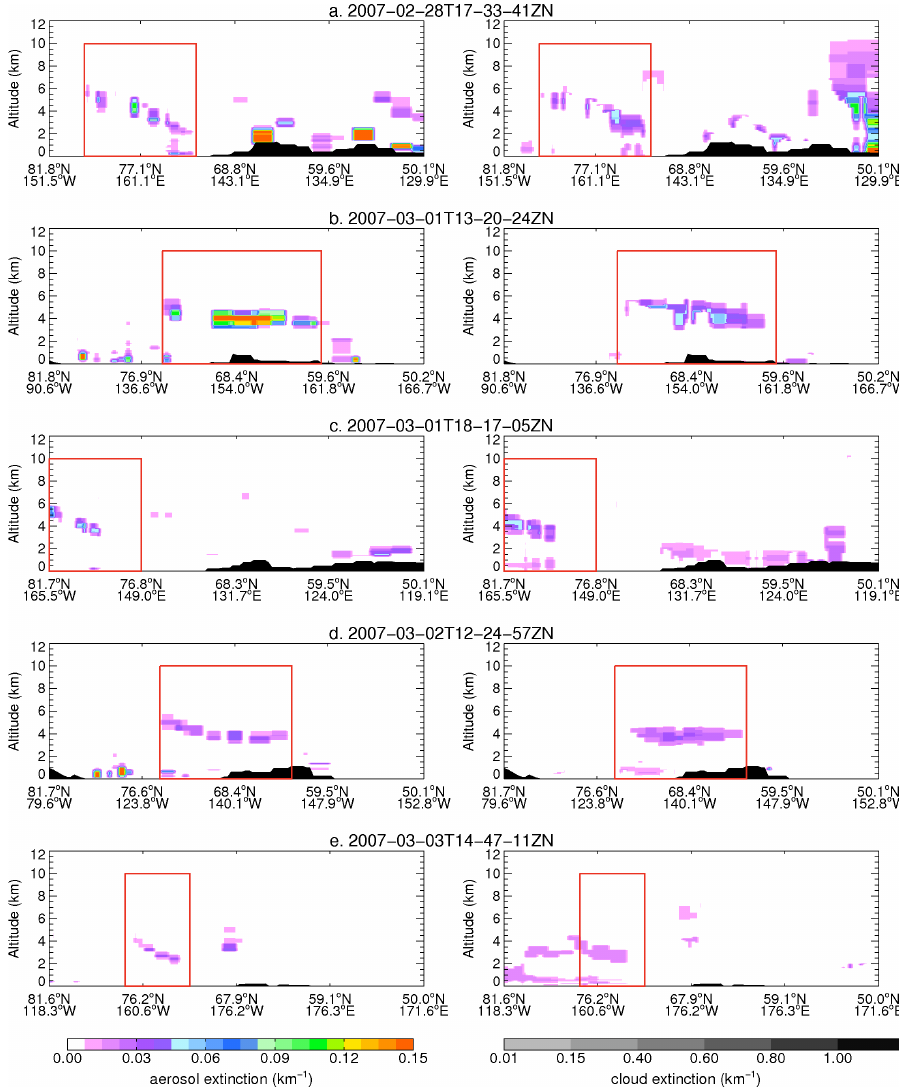
Figure 4. Same as Figure 2, but with the CALIOP extinction gridded onto the GEOS-Chem horizontal and vertical grid (left panels). The GEOS-Chem extinction cross sections (right panels) take into account the CALIOP altitude-dependent backscatter sensitivity threshold. In addition, model extinction is displayed only under cloud free conditions for better comparison to CALIOP. from the planetary boundary layer to the free